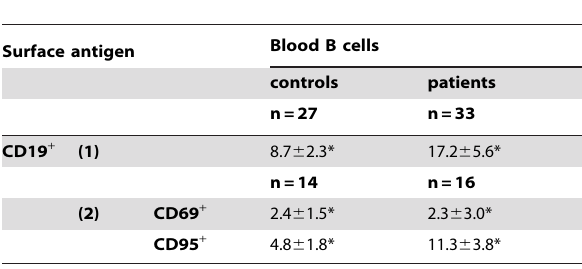
Table 2. B cells (CD19 + ) and B-cell activation markers (CD69 + and CD95 + ) in peripheral blood mononuclear cells for surveys 1 and 2.